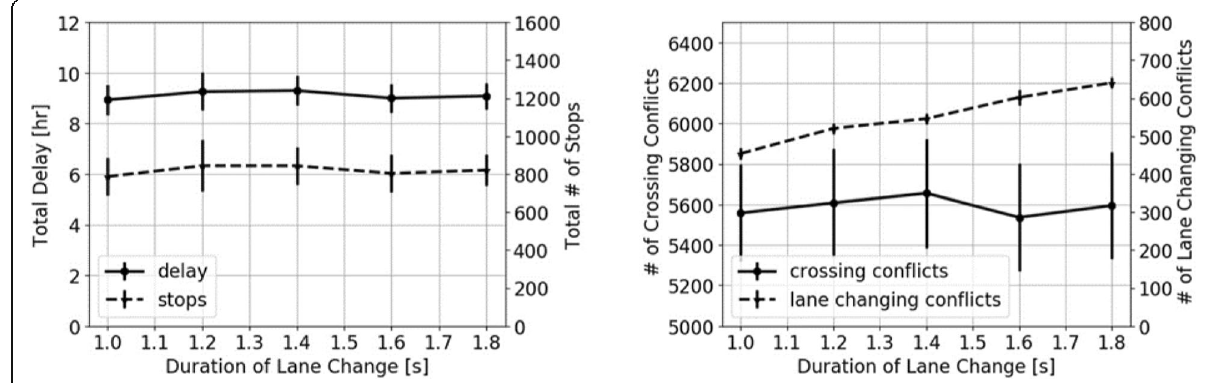
Fig. 8 Impact of lane-changing interval on delay, stops and